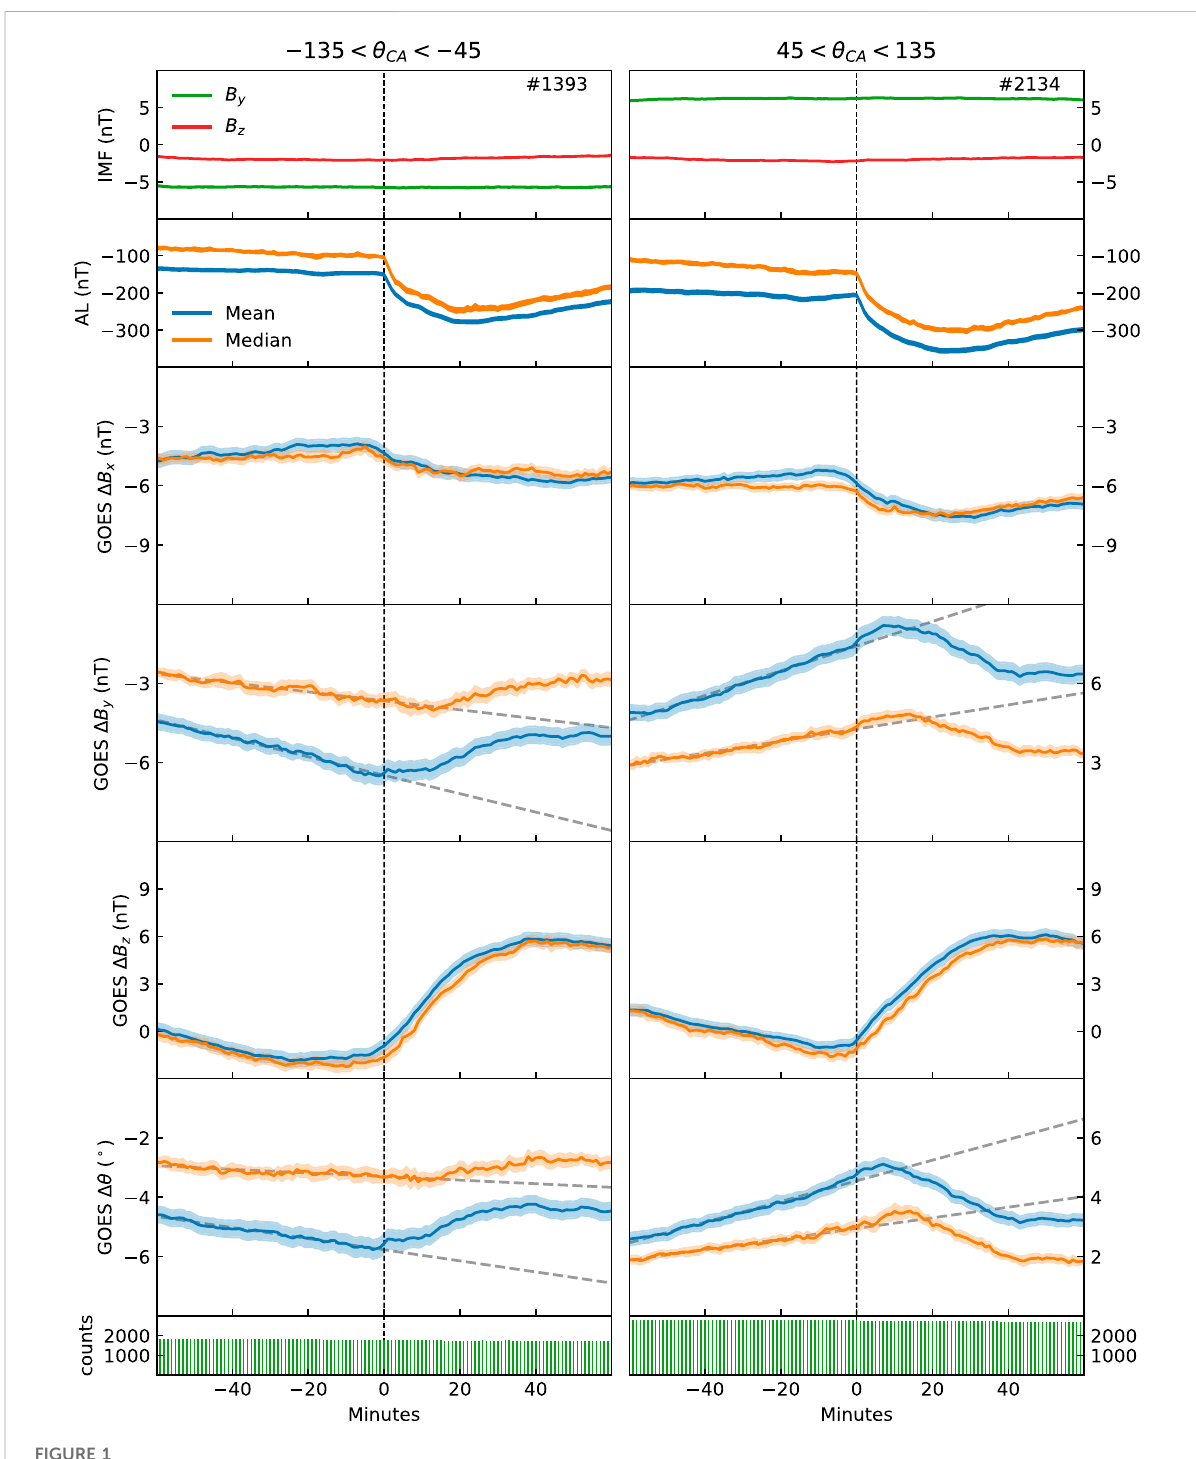
FIGURE 1 Superposed epoch analysis relative to substorm onset as identi fi ed by the N&G onset list. The rows display IMF B y (green) and B z (red), AL index, GOES Δ B x , Δ B y , Δ B z , Δ θ and number of observations. Mean is blue, median is orange and curve widths indicate standard error.